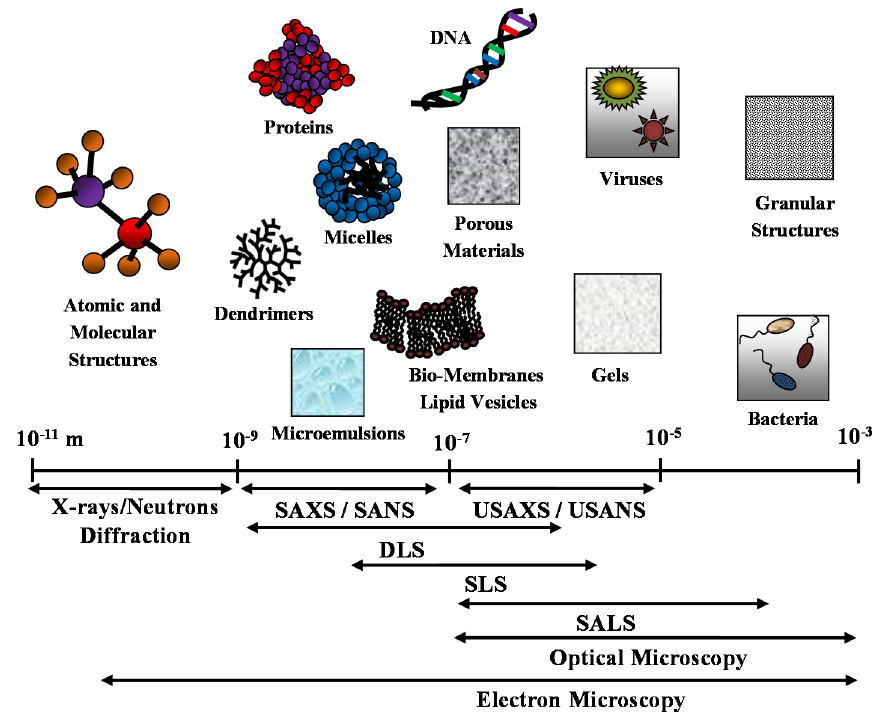
Figure 1. Different space resolution of the main scattering techniques: small angle X-rays and neutrons scattering (SAXS and SANS), ultra-SAXS and ultra-SANS (USAXS and USANS) and dynamic, static and small angle light scattering (DLS, SLS and SALS). Comparison with complementary optical and electron microscopy techniques.